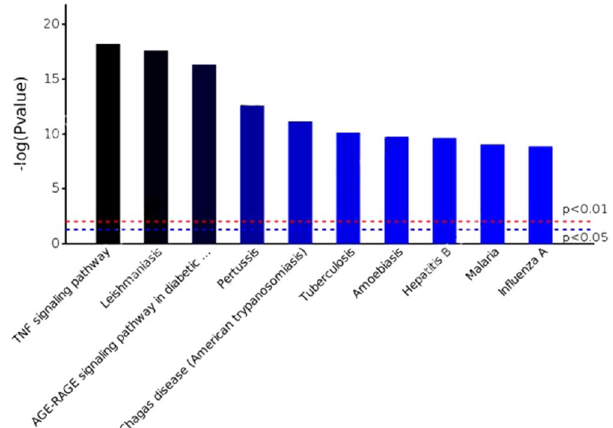
Figure 5. Histogram of the top 10 pathways involving GAS30 members. The horizontal axis indicates pathway names, whereas the vertical coordinates indicate the negative values of the log of the p-values: e.g., the horizontal dashed-lines in red and in blue have p-values equal to 0.01 and 0.05, respectively, and their vertical coordinates are equal to − log(0.01) = 2 and − log(0.05) = 1.3,